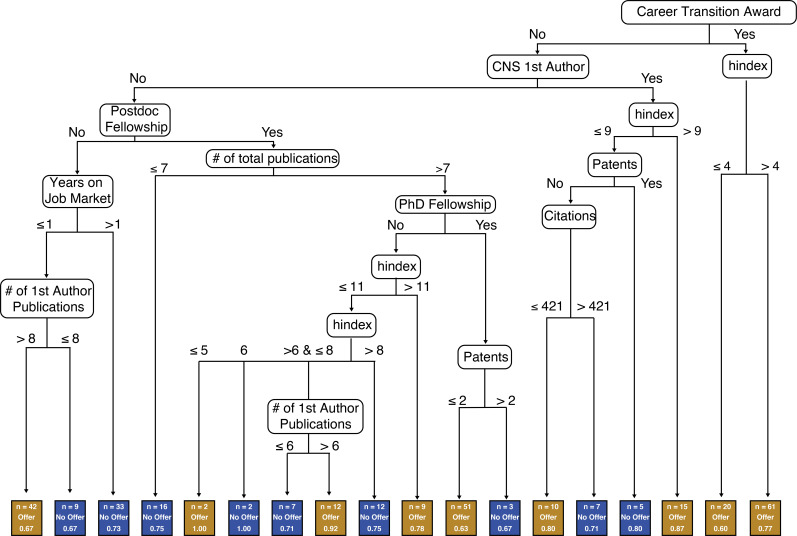
Visualization of possible paths to an offer using the C5.0 decision tree algorithm.Each rounded node represents an independent variable and each rectangular node represents one of two possible outcomes (offer (gold) or no offer (blue)). Only those variables in Figure 5B were included. In the case of binary variables such as funding and fellowships, ">0" indicates a "yes" and "<=0" indicates a "no". All other variables, except for h-index, were split based on counts. The outcome nodes are labeled with three pieces of information: (Cyranoski et al., 2011) the number of applicants who fell into the given branch (n), (Ghaffarzadegan et al., 2015) the most common outcome in that branch, and (Schillebeeckx et al., 2013) the fraction of individuals with that outcome. For example, the rightmost branch shows applicants who had a career transition award and h-index >4. They constitute the largest group in our dataset (61 individuals). However, only 77% of these applicants received an offer. Similarly, the second and third largest groups included 51 applicants (63% with offer) and 42 applicants (67% with offer) respectively (see eighth outcome box from right and leftmost box). These three groups accounted for 48.6% of our survey respondents. Note that while decision trees have often been used as prediction models, this tree is only reflective of our dataset and choice of algorithm and parameters. We have used this solely for visualization purposes and advise against using this prospectively to evaluate chances of success on the job market as there may be alternative trees that are equally plausible and accurate. In fact, the accuracy of the overall decision tree in distinguishing between candidates with offers and those without was only 58.5%. Furthermore, no group with more than two applicants consisted purely of those with offers and those without. Even in the nine groups where the most common outcome was "no offer", on average, 25% of the applicants did receive offers.